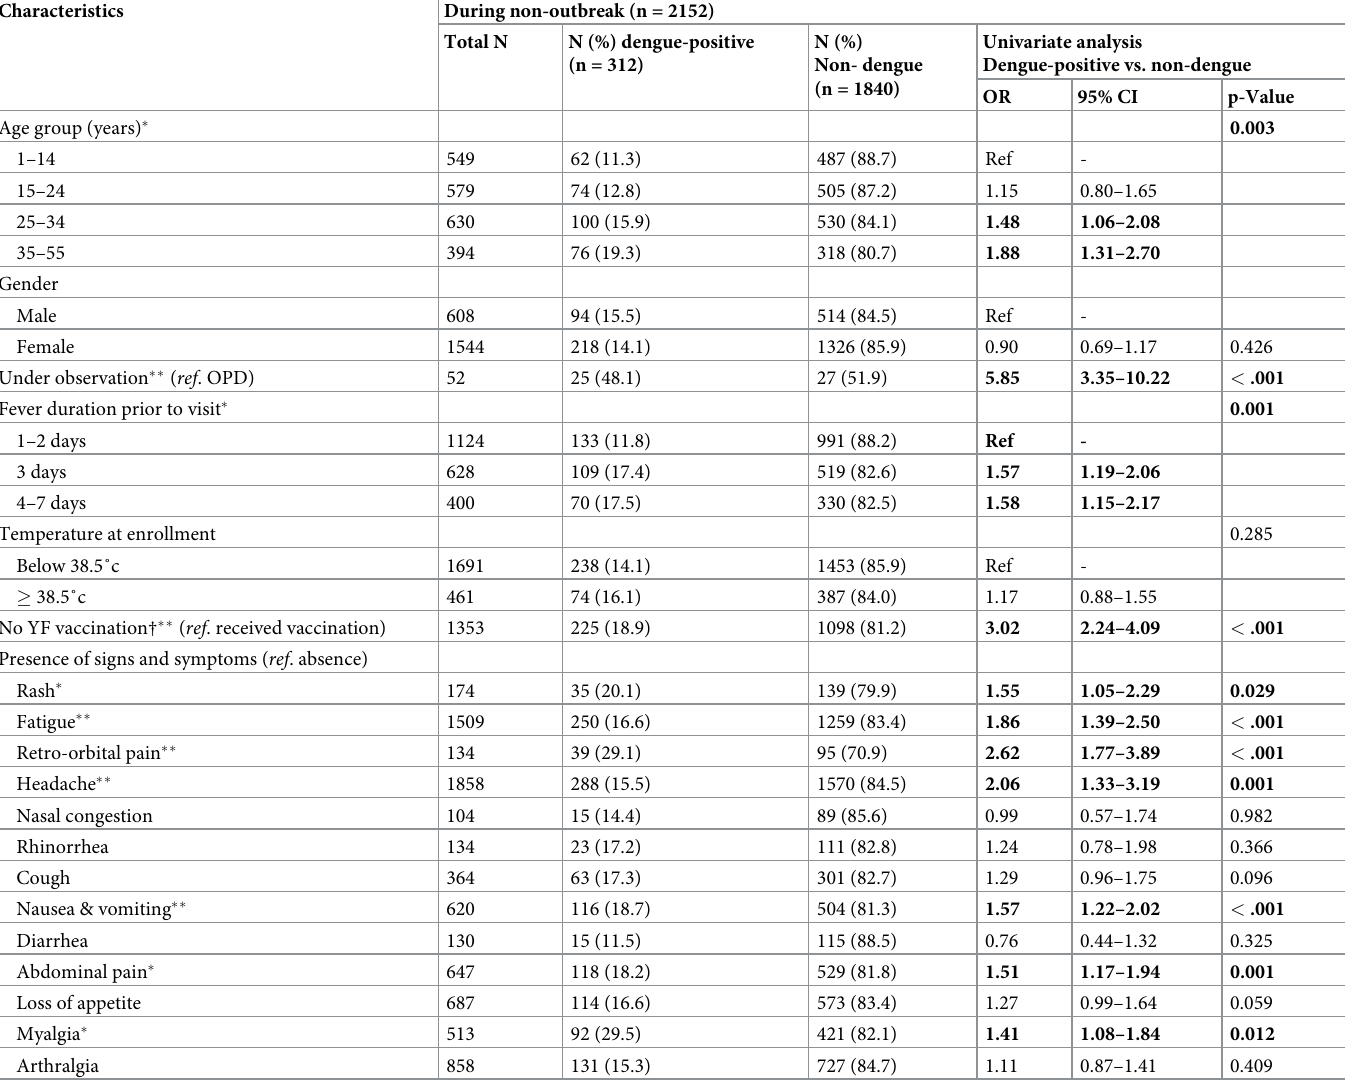
Table 4. Univariate logistic analyses showing significant indicators and their odds ratios of dengue-positivity during non-outbreak periods, from the facility-based fever surveillance established in Ouagadougou, Burkina Faso, between December 2014 and February 2017.